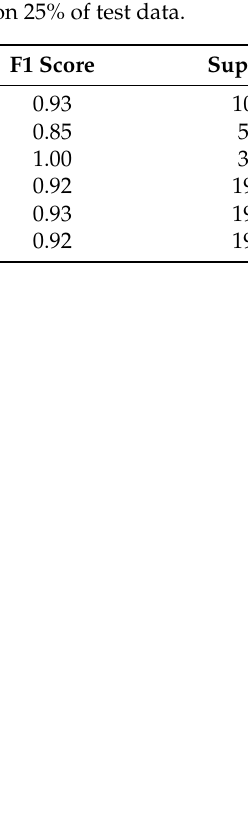
Table 5. Precision, Recall, and F1 score for the combined image on 25% of test data.